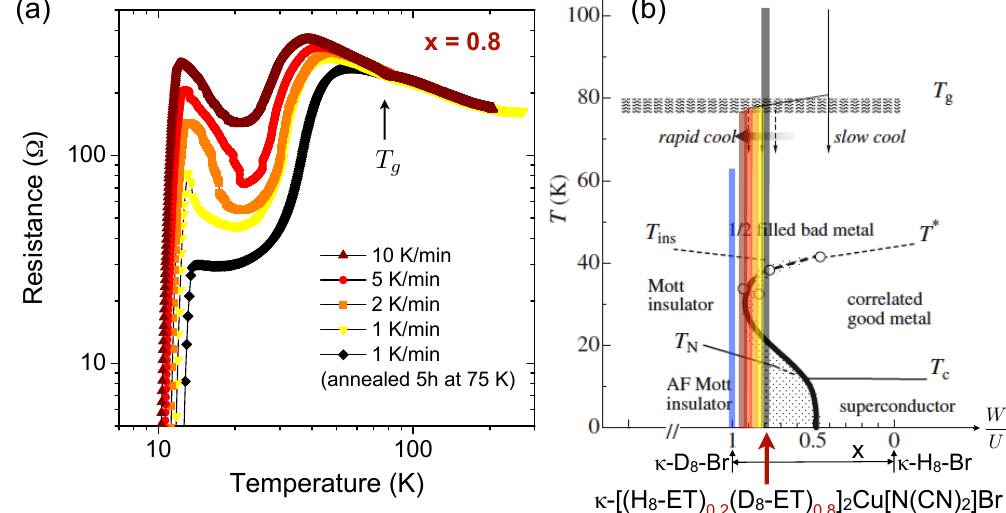
Figure 10. Tuning a partially-deuterated sample κ -[(H 8 -ET) 1 x (D 8 -ET) x ] 2 Cu[N(CN) 2 ]Br with x = 0.8 − through the Mott transition. ( a ) resistance measurements for various cooling rates q ; ( b ) generic phase diagram after [21]. Open circles indicate values taken from the literature of the second-order critical end point of the first-order Mott MIT (thick solid curve). The arrow indicates the position of the slowly cooled, pristine sample in the generic phase diagram. The change of the sample position with q is schematically indicated by the colored lines. For comparison, the blue color represents fully-deuterated κ -D 8 -Br shown in Figure7. Reprinted with permission from [53]. Copyright (2015) by the American Physical